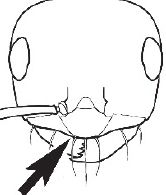
79 Clypeus folded back abruptly slightly below its midpoint, so that anterior portion projects as a protuberance at about 90° to mandible; clypeal psammophore placed along line of demarcation (rare, localised; QLD) (Fig. 57a–g) .............. gilliatensis